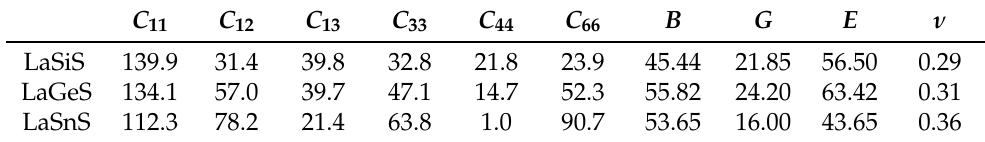
Table 2. The calculated elastic constants ( C ij ), bulk modulus ( B ), shear modulus ( G ), Young’s modulus ( E ) in units of GPa, and Poisson’s ratio ( ν ) for the La X S